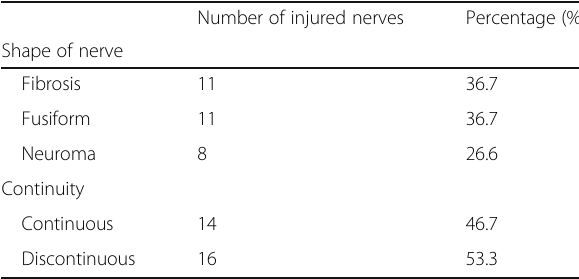
Table 3 Shape and continuity of the examined nerves by